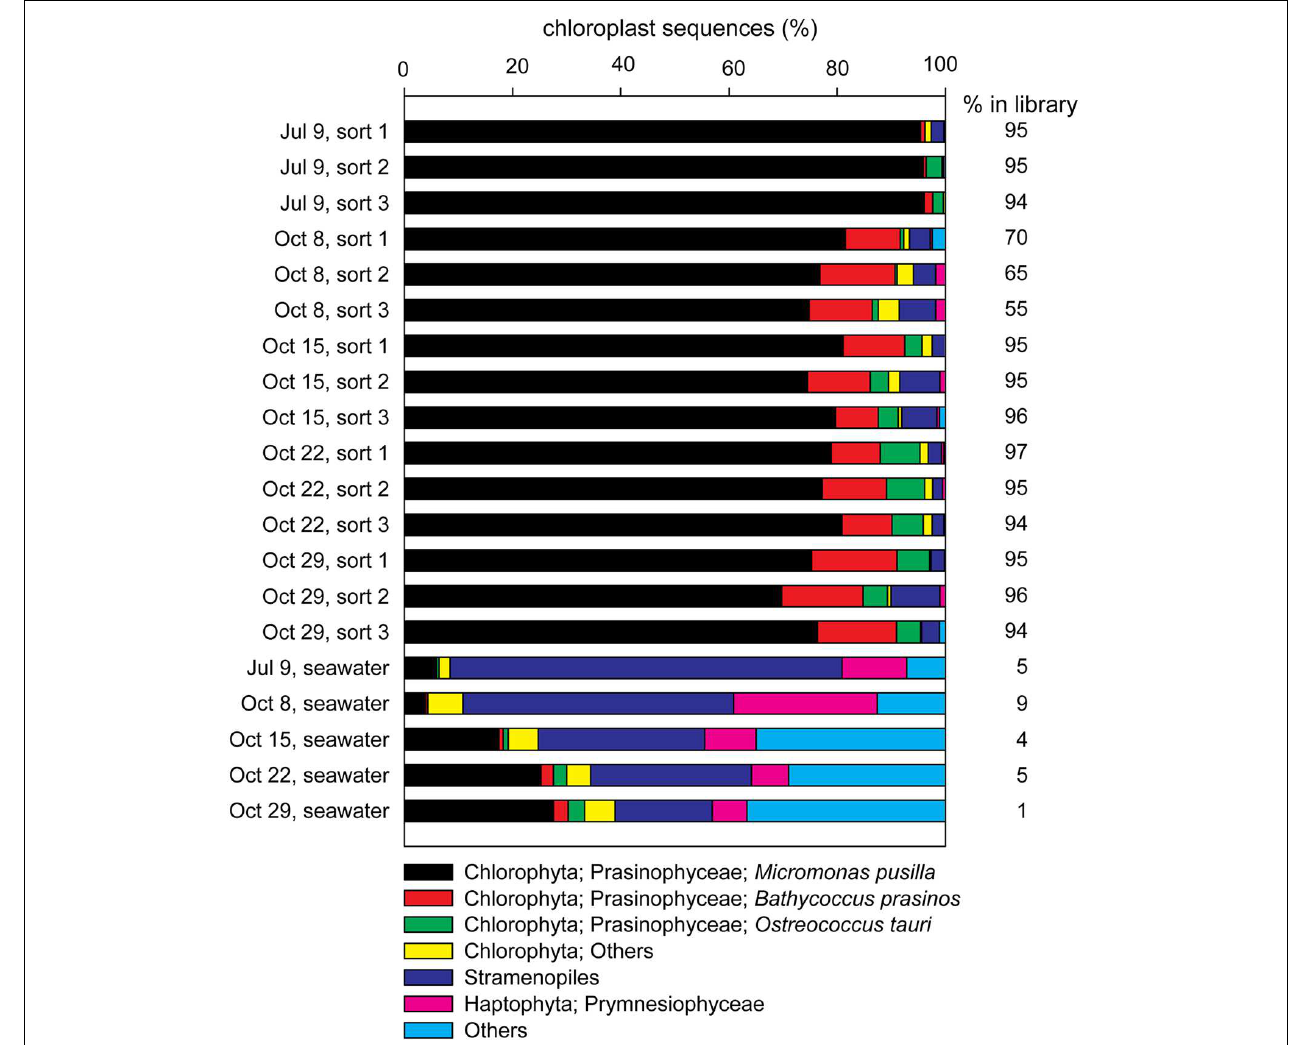
FIGURE 4 | Contributions of the most frequently occurring eukaryotic phyla among chloroplast sequences detected in each of the sorted photosynthetic picoeukaryote samples (1,000 P1 cells, triplicate samples) and the corresponding seawater samples (0.2–10 µ m) for each sampling date. The percentage of chloroplast sequences within each library is indicated to the right of each